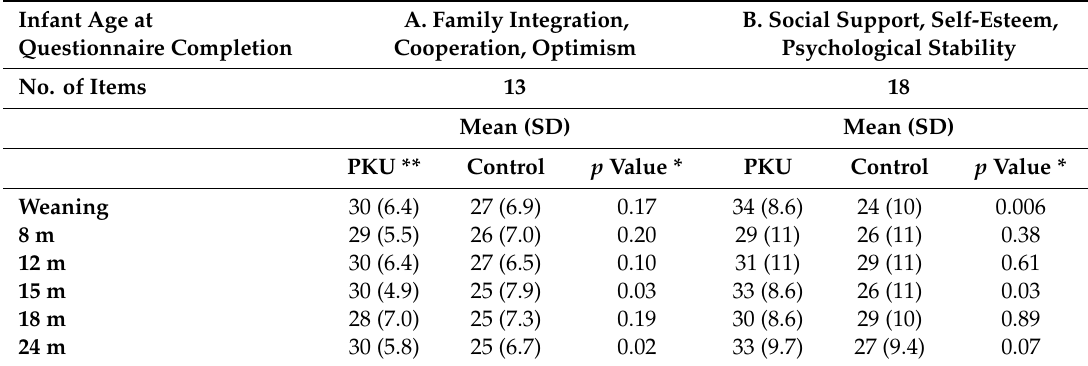
Table 2. Means and standard deviation scores for PKU CHIP subsets compared with control